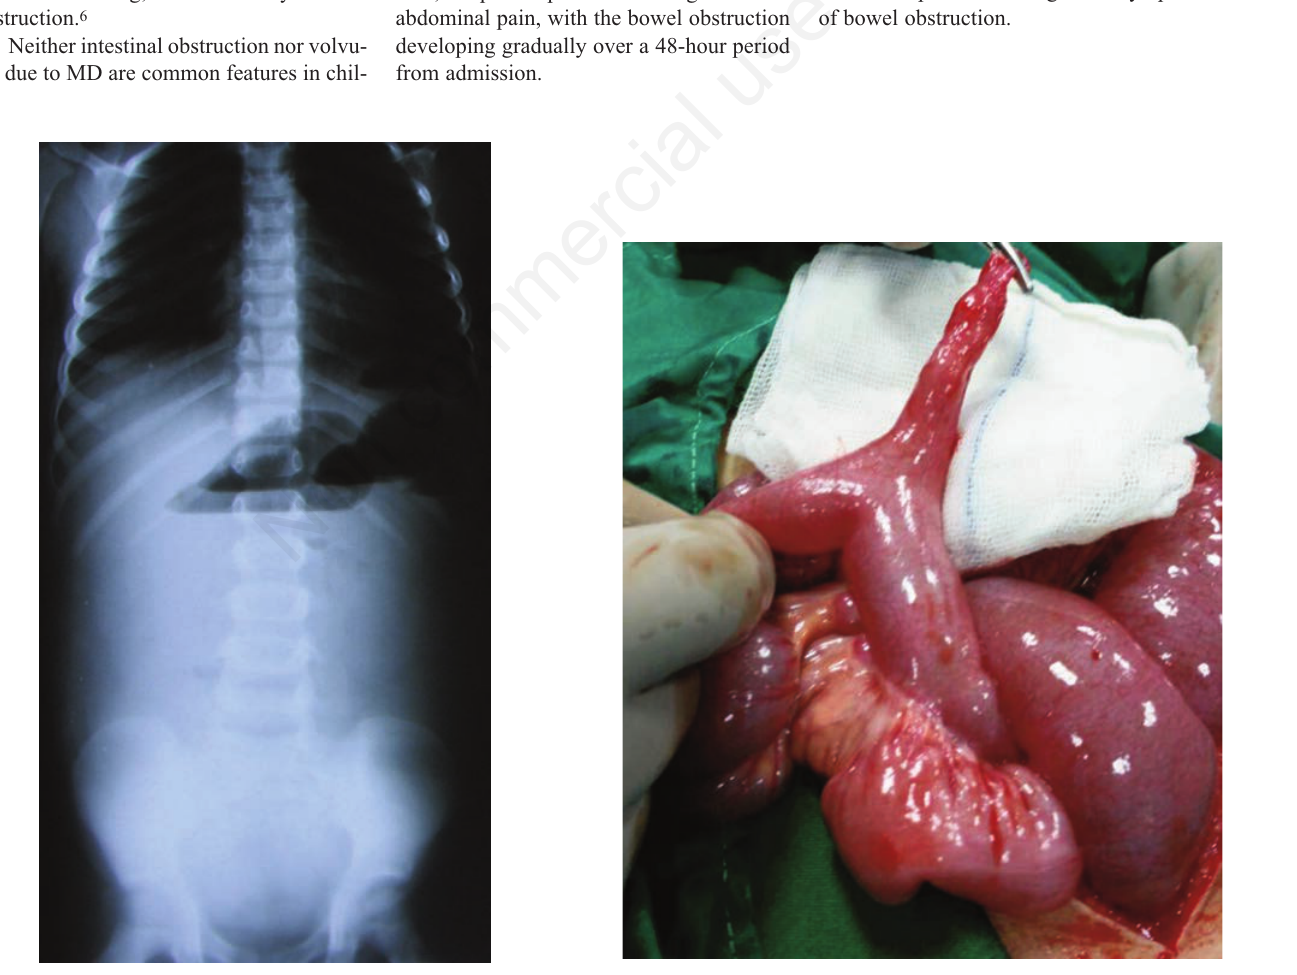
Figure 2. Intraoperative photograph showing portion of bowel obstruction due to Meckel’s diverticulum ischemic